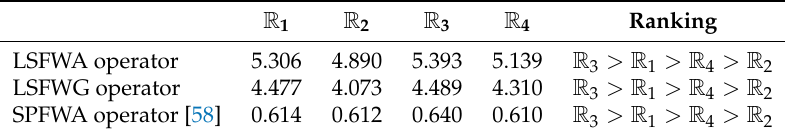
Table 7. Ranking of different